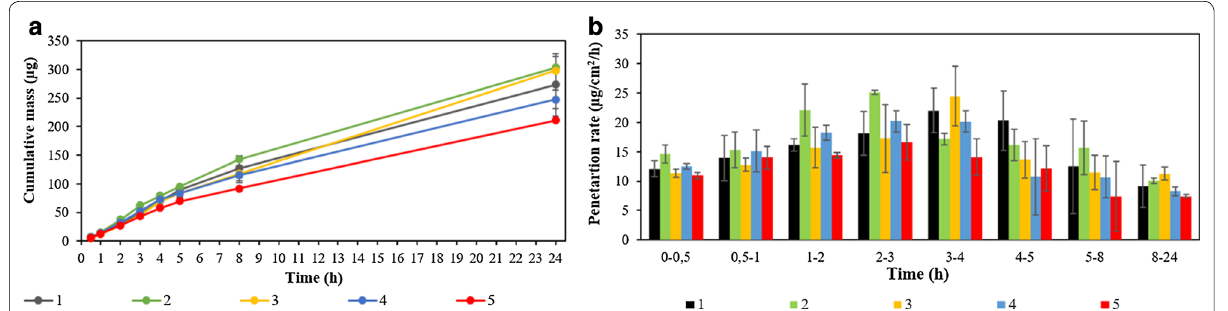
Fig. 5 a Mass of test substance in the acceptor fluid during the 24-h experiment: (1) Eugenol, (2) EDChA, (3) ETChA, (4) DChAA, (5) TChAA. b The penetration rate of test substances through the skin during the 24-h experiment: (1) Eugenol, (2) EDChA, (3) ETChA, (4) DChAA, (5)